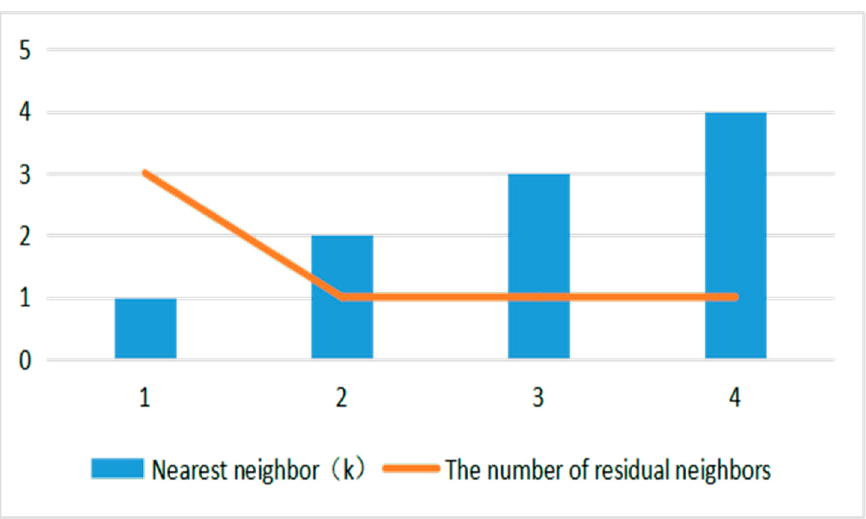
Figure 7. With the gradual increase of k, the changes of the residual neighbors of the data points .